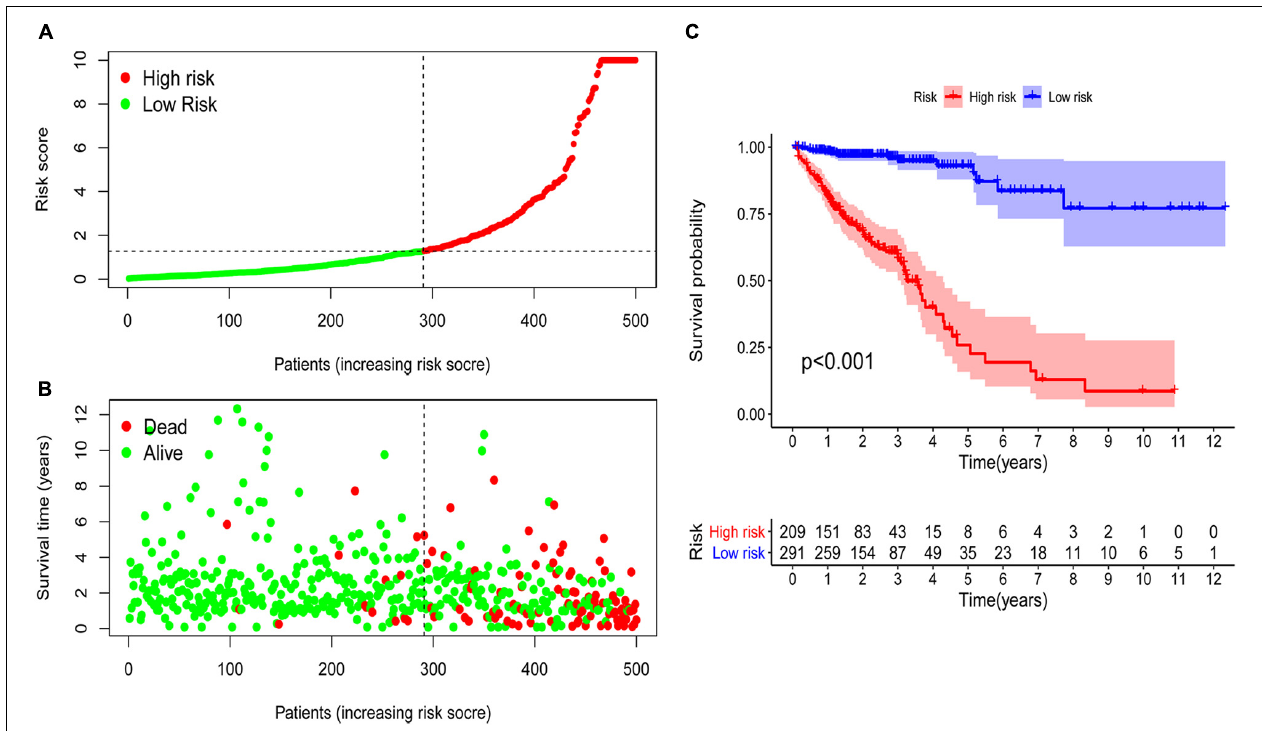
FIGURE 3 | Risk assessment model for survival prediction. The risk scores (A) and survival time (B) of each case were shown. (C) The survival time of the high-risk group was significantly shorter than that of the low-risk group.